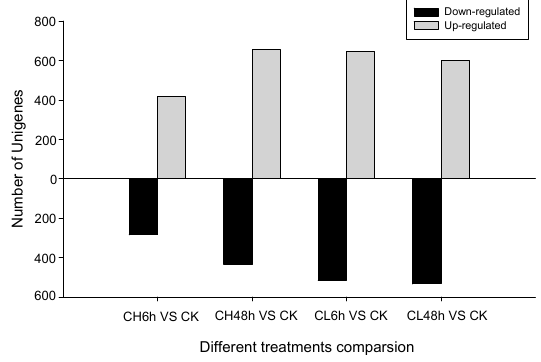
Figure 1. The number of up- and down-regulated unigenes is more than two-fold when compared between different treatments. CK: Control; CH: Chlorpyrifos; CL: Clothianidin; 6 and 48 h: treatment with Chlorpyrifos or Clothianidin after 6 or 48 h.